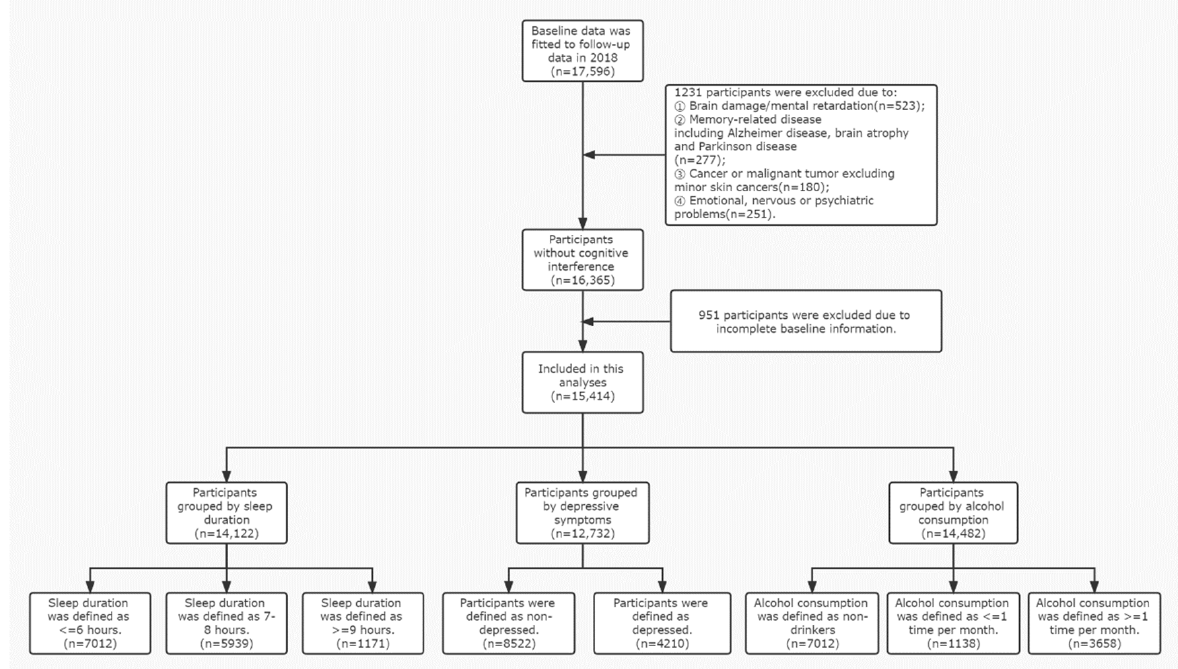
Figure 1. The process of participants’ selection and